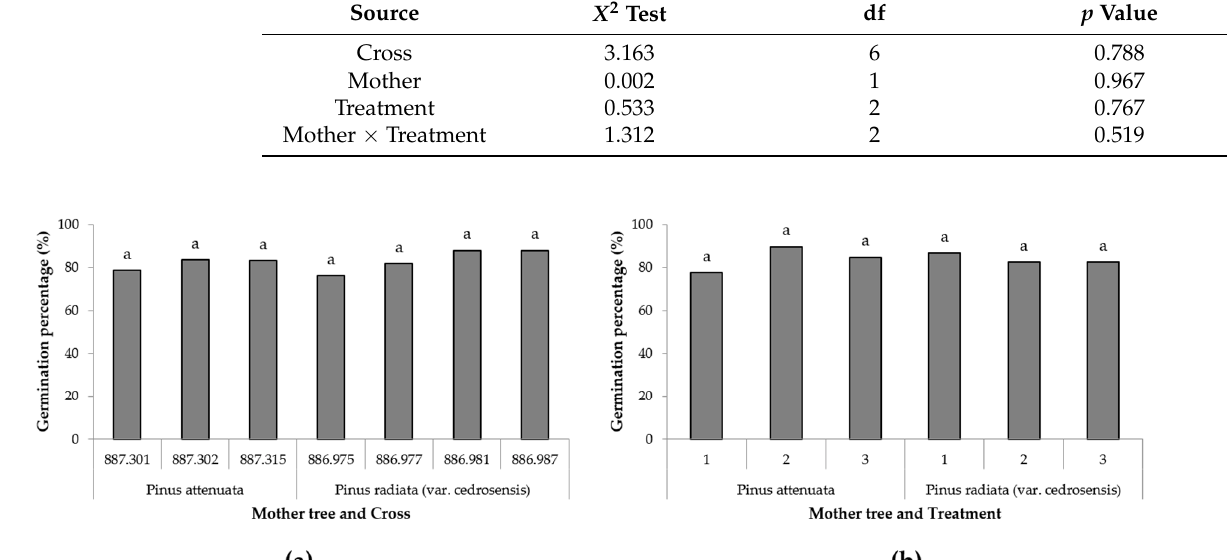
Figure 3. ( a ) Germination percentages in embryogenic cell lines in which P. attenuata acted as the mother tree (crosses 887.301, 887.302, 887.315) and in which P. radiata var. cedrosensis acted as the mother (crosses 886.975, 886.977, 886.981, 886.987). ( b ) Maturation percentages in embryogenic cell lines from different initiation treatments (1, 2 and 3) in the two mother species. Different letters indicate significant differences by Tukey’s post hoc test ( p < 0.05). Table 5. Height of somatic plants (cm) from embryogenic cell lines in which P. attenuata or P. radi- ata var. cedrosensis acted as the mother and from different initiation treatments (1, 2 and 3) after six months in the greenhouse.